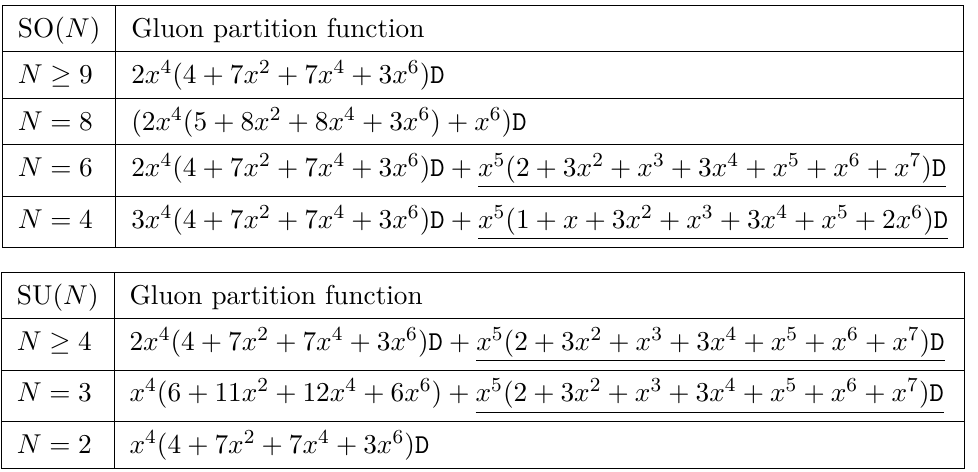
Table 7 . Partition function over the space of Lagrangians in D = 5 involving four F a D ≡ 1 / ((1 − x 4 )(1 − x 6 )) . Contribution of M non-inv is underlined. The rest is the contribution of M inv . Partition function for SO(5) and SO(7) is the same as that for SO( N ) for N ≥ 9 .